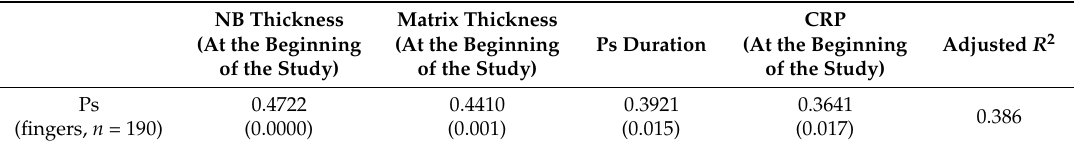
Table 6. The regression coefficients in modelling for finger extensor tendon thickness in psoriatic patients treated with